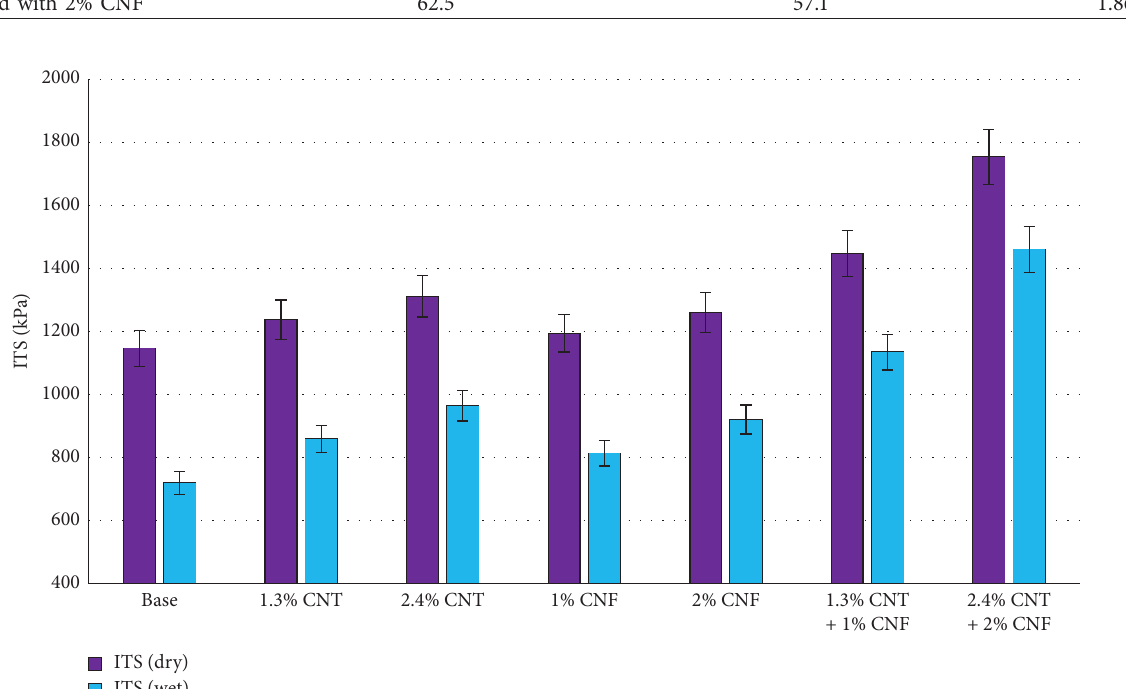
Figure 3: The results of the ITS test in wet and dry conditions.